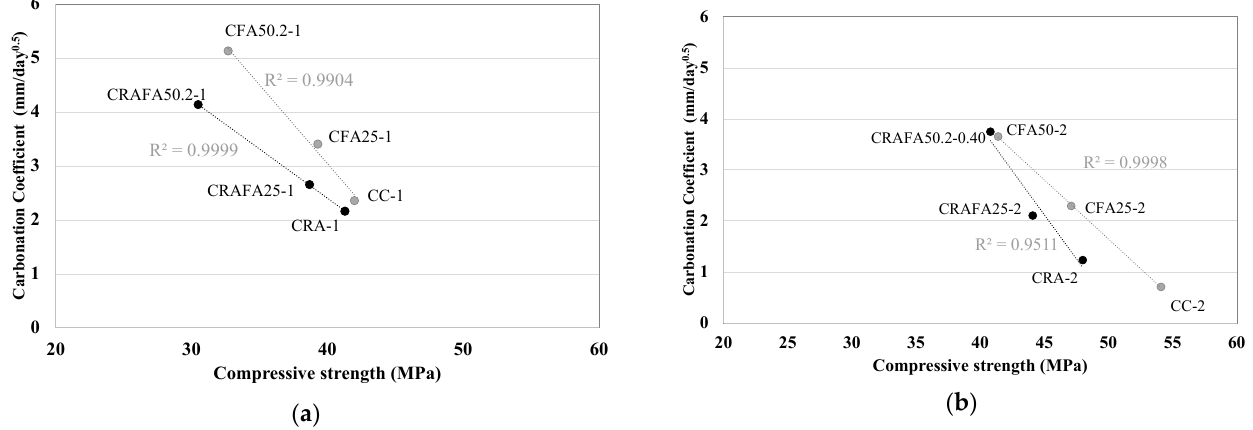
Figure 8. Compressive strength versus carbonation depth for all the concretes. ( a ) Series 1 and ( b ) Series 2. The concretes produced with RCA are represented by the black dots.